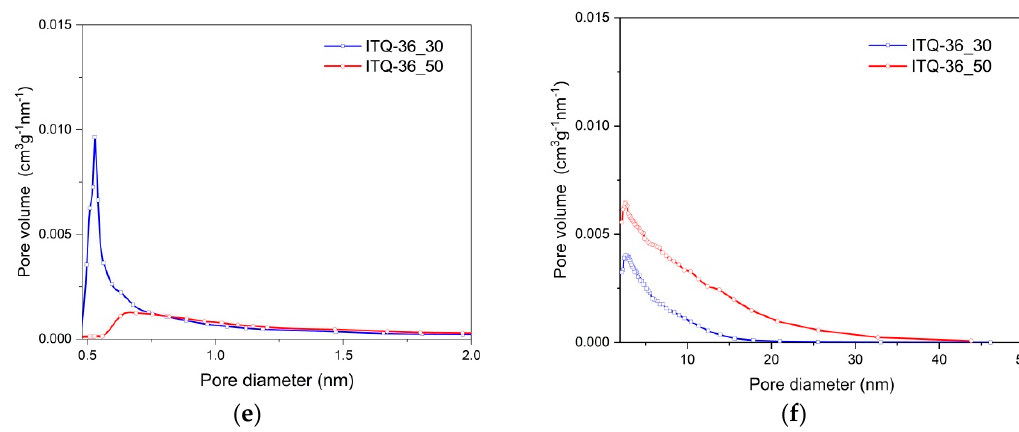
Figure 3. Pore size distributions of FER, ITQ-6 and ITQ-36 in micropore ( left —( a , c , e ), respectively) and mesopore range ( right —( b , d , f ), respectively).